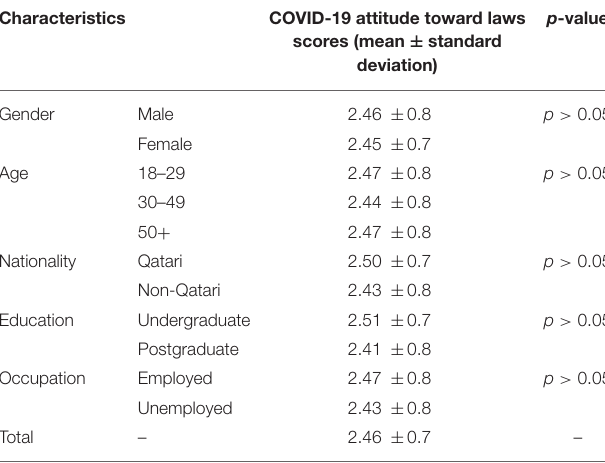
TABLE 3 | Coronavirus disease 2019 safe practice scores by demographic variables. Characteristics